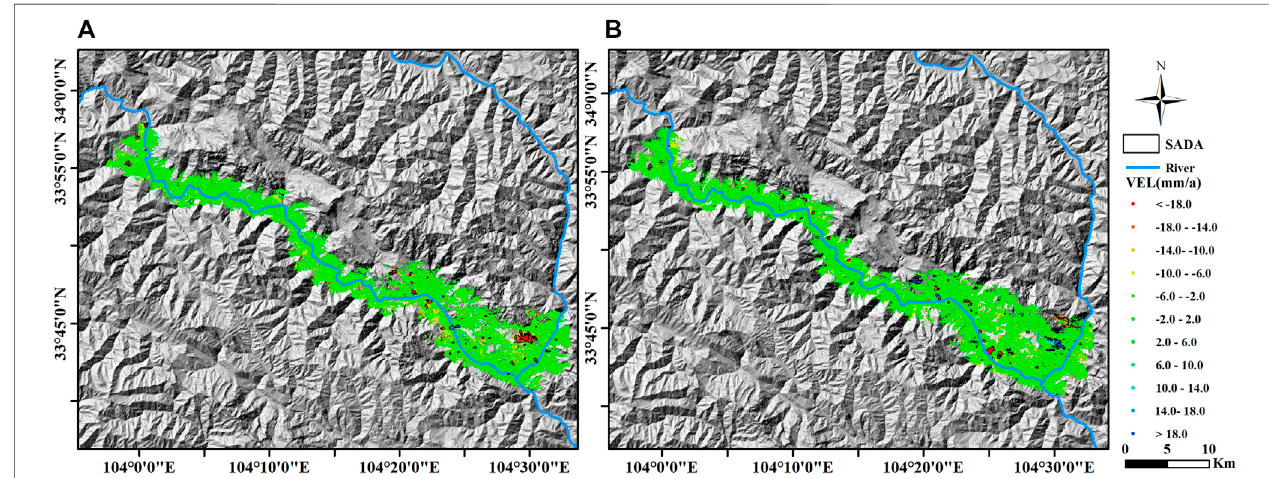
FIGURE 5 | Average deformation velocities in the LOS direction are derived from (A) ascending images and (B) descending images. The black boundary is the extent of each SADA.